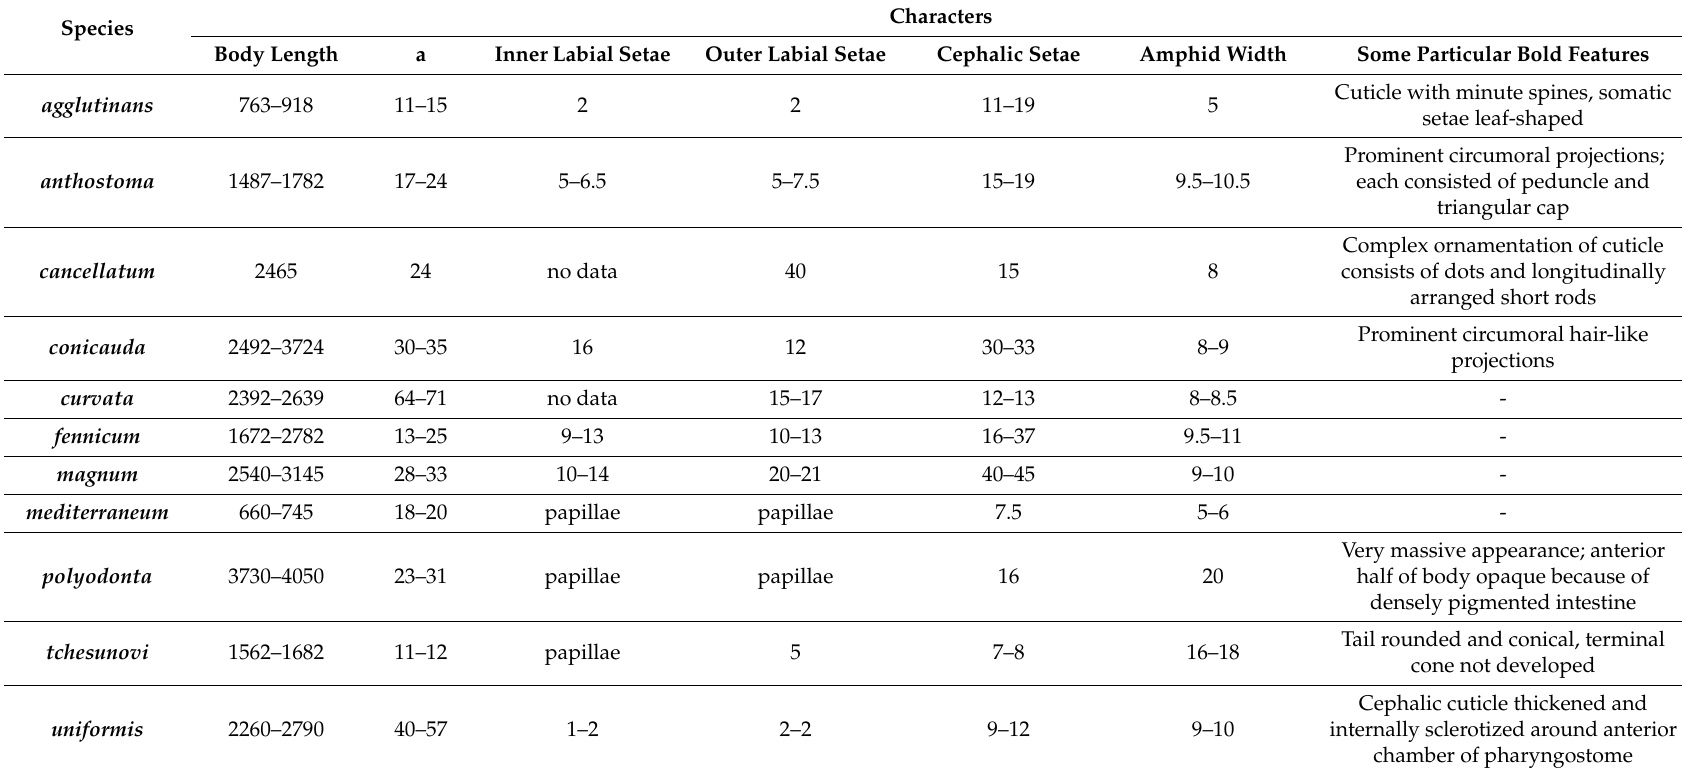
Table 2. Gammanema valid species, comparison of